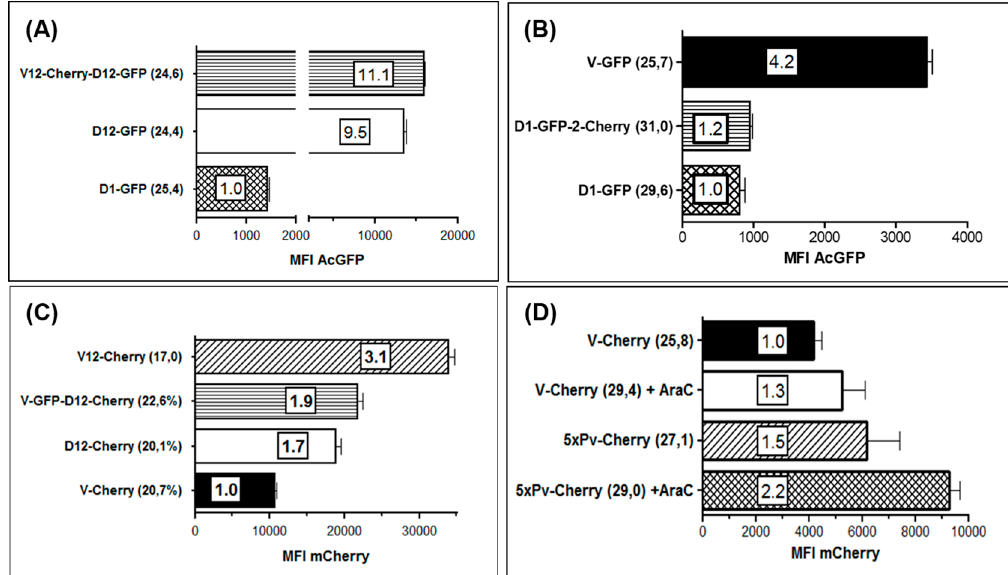
Figure 7. Comparison of strength of the promoters Pv, eP1 and eP2 by flow cytometry. Vero cells were infected in triplicates with the indicated ORFV recombinants for 22 h and the mean fluorescence intensity (MFI) was measured by flow cytometry. The numbers in parentheses behind the name of each recombinant indicate the percentage of positive cells determined by flow cytometry. The numbers in the bars denote the multiple of the particular lowest MFI set to 1.0. ( A ) Activities of eP1 and eP2 in insertion site D directing expression of AcGFP gene. The lowest MFI was found with promoter eP1 (recombinant D1-GFP) and set to 1.0, whereas expression from eP2 was 11.1- or 9.5-fold stronger after infection with V12-Chery-D12-GFP or D12-GFP, respectively. ( B ) Again, the lowest promoter activity was demonstrated from eP1 (recombinant D1-GFP and D1-GFP-2-Cherry) but 4.2-fold higher expression strength by promoter PV. ( C ) Expression of mCherry in insertion site V under control of Pv (recombinant V-Cherry) yielded the lowest MFI (set to 1.0) but was 3.1-fold higher when controlled by eP2 (recombinant V12-Cherry). Expression in the D locus showed that the eP2 led to 1.9 higher (recombinant V-GFP-D12-Cherry) or 1.7 higher (recombinant D12-Cherry) MFI. ( D ) The effect of a tandem arrangement of 5 core elements of Pv (recombinant 5xPv-Cherry) on the expression of mCherry in the V locus was compared to that of the single Pv (V-Cherry; set to 1.0). Vero cells were infected